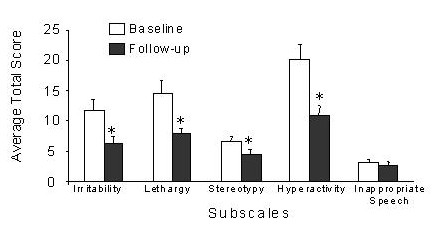
Effect of Pioglitazone on behavior improvement. The average (mean ± s.d.) of the total scores for the 5 subscales of the ABC was calculated for 25 patients before treatment (baseline) and after 3–4 months of treatment with Pioglitazone. *, P < .05 unpaired T-test.